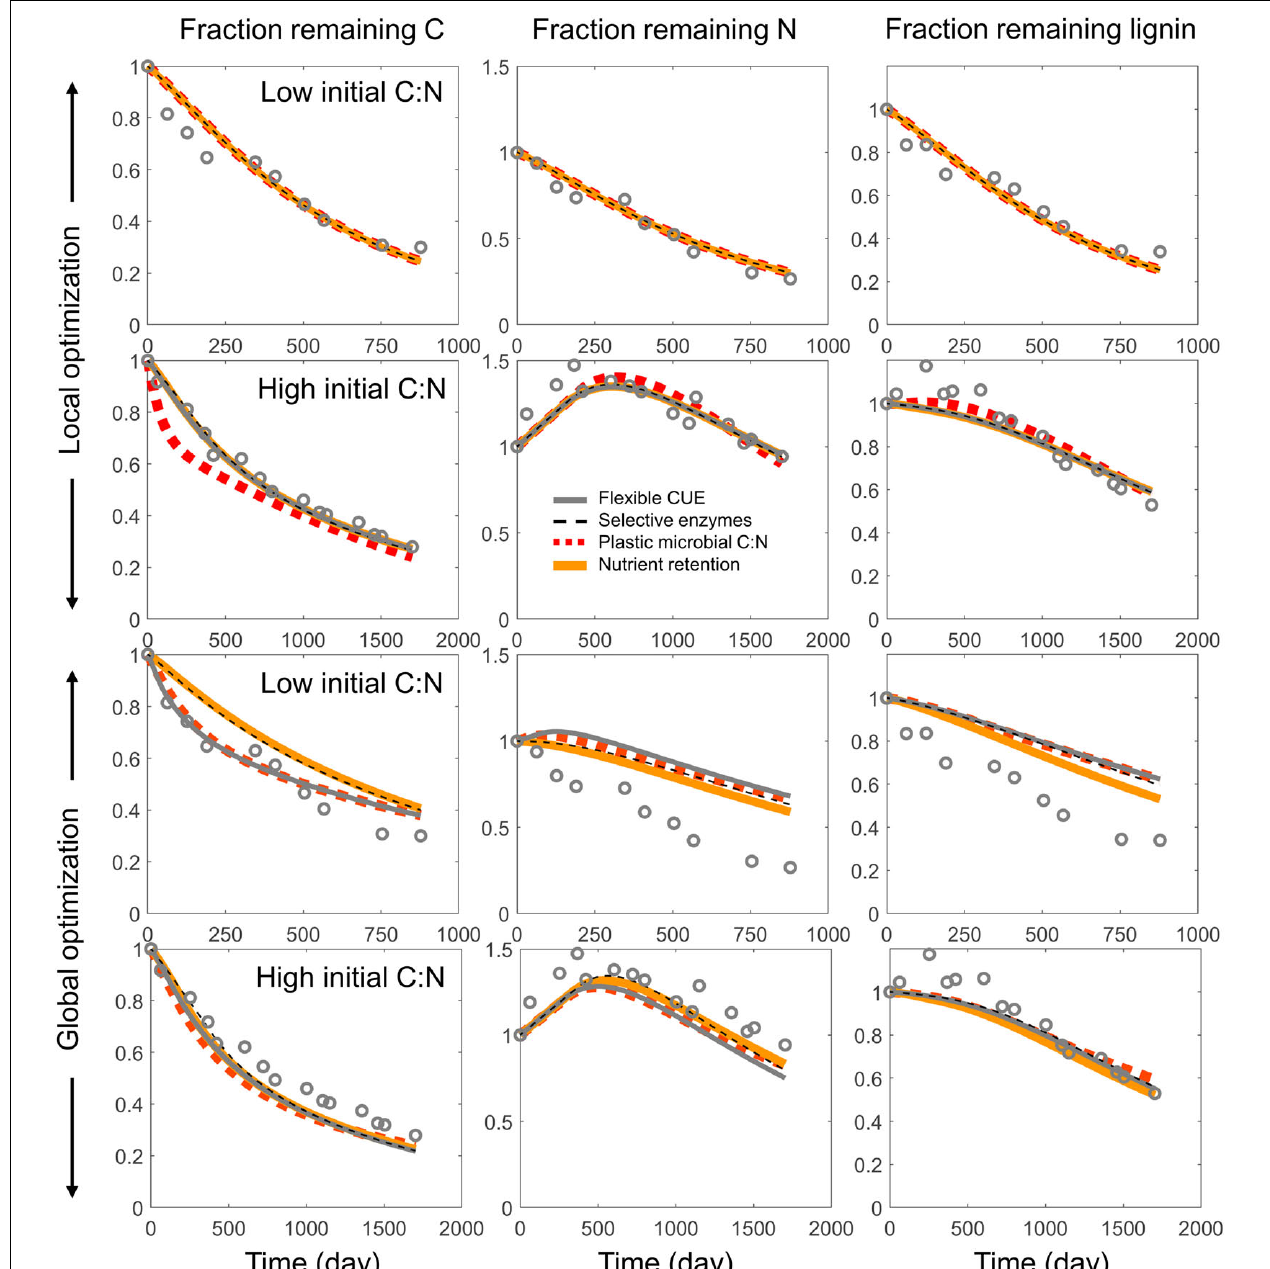
FIGURE 5 | Examples of model fitting using the local (top two rows) and global (bottom two rows) parameter optimization approaches, applied to each of the four resource use modes (same line styles as in Figures 2 , 3 ). The fractions of remaining total C, total N, and lignin ( C O ) are shown in the left, center, and right columns, respectively. Two litter types with contrasting initial C:N ratio were chosen as examples–one with high initial C:N [ Pinus sylvestris , C:N = 132, from Berg and McClaugherty (1989)], and one with low initial C:N [ Pterostyrax hispida , C:N = 14, from Osono and Takeda (2004,